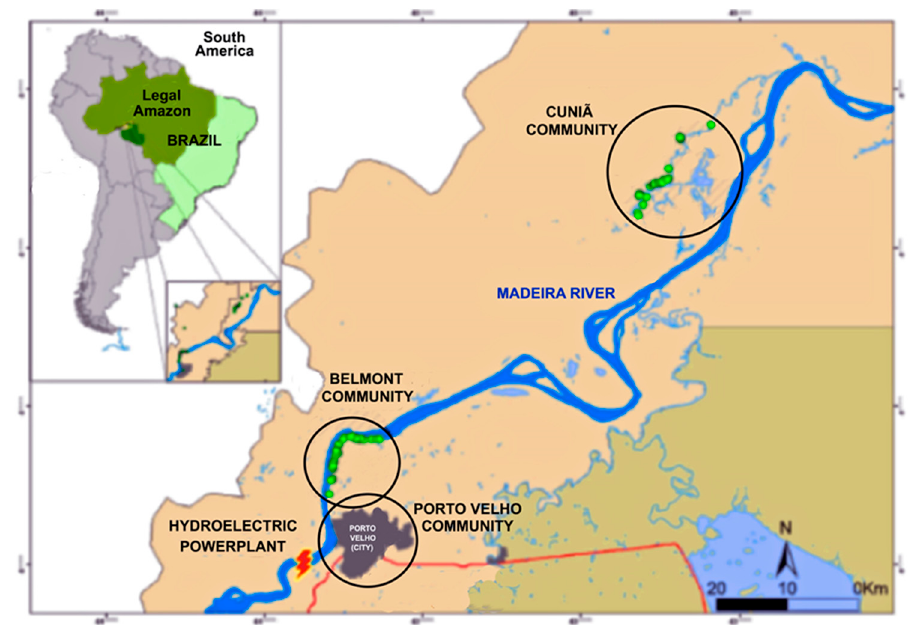
Figure 1. Map of the study area. Cuniã and Belmont are located downstream of Porto Velho city, in the state of Rondônia, Brazil. The circles represent the three communities (Belmont, Cuniã and Porto Velho) sampled in this study [29]. Reproduced with permission from Claudia M. Vega, Biological Trace Element Research; published by Springer Link, 2017.